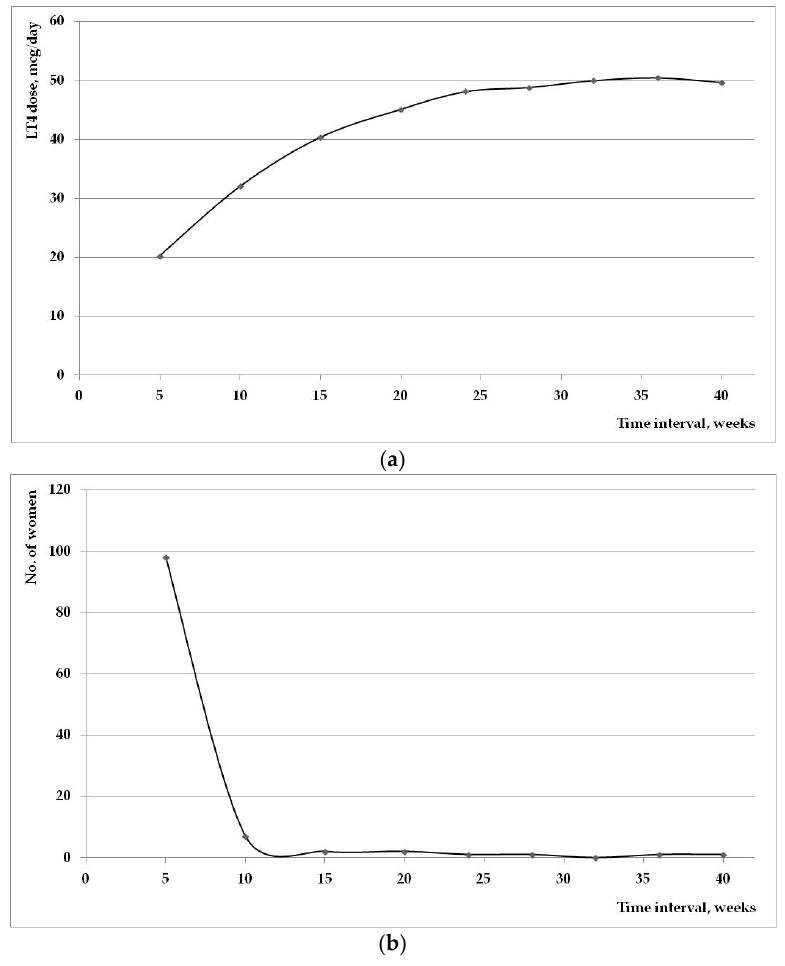
Figure 2. ( a ) Mean supplemental LT4 used dose during the evolution of pregnancy; ( b ) the number of cases that required initiation of LT4 therapy during the pregnancy.